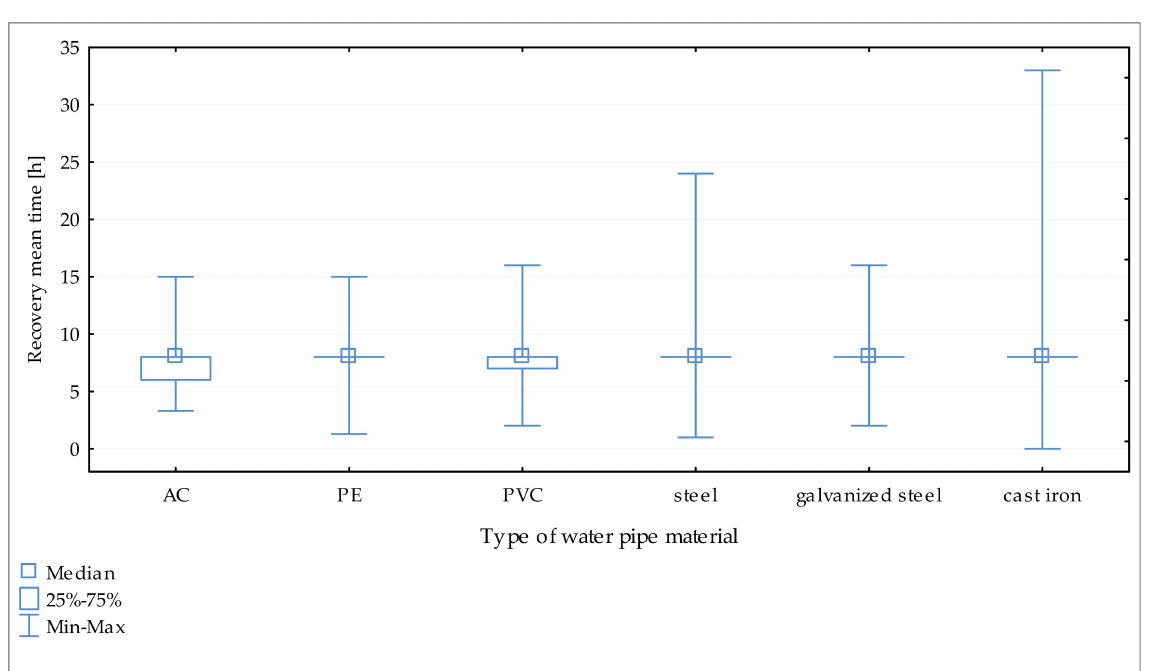
Figure 7. Recovery meantime vs. water pipe materials.